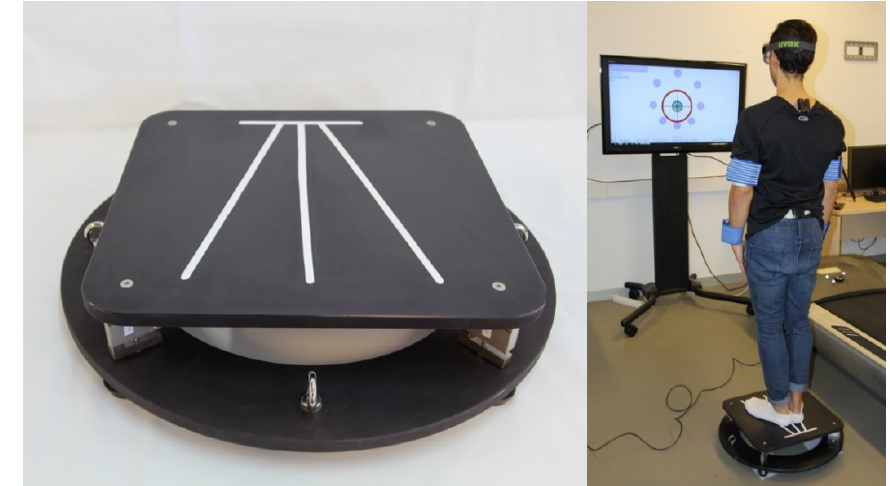
Figure 1. Stabilometric platform and environmental test condition.